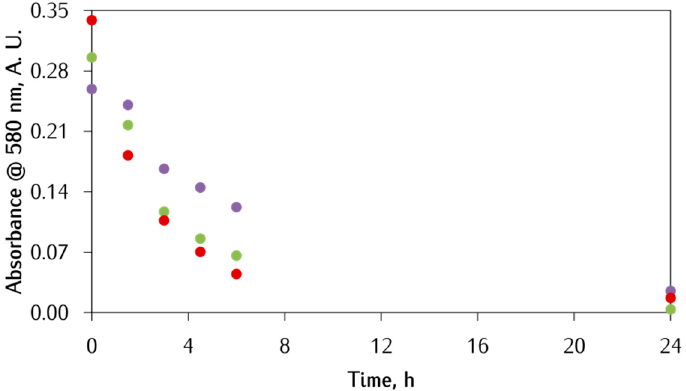
Figure 7. Kinetic traces of DA (200 µ M) oxidation in Mops buffer pH 7.0 and 37 ◦ C in the presence of 100 µ M of Fe II (red) and 200 µ M (2 equiv.) of peptide (Ac- α S 119–132 : green, Ac- α S p S 119–132 : purple).